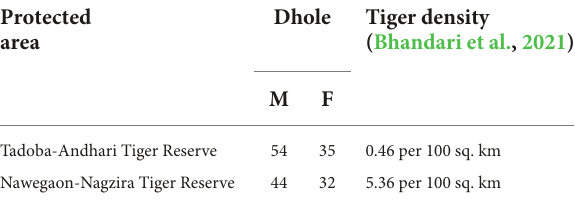
TABLE 2 Detailed estimates of genetic diversity (number of alleles per locus, expected (He), and observed (Ho) heterozygosity for males and females).